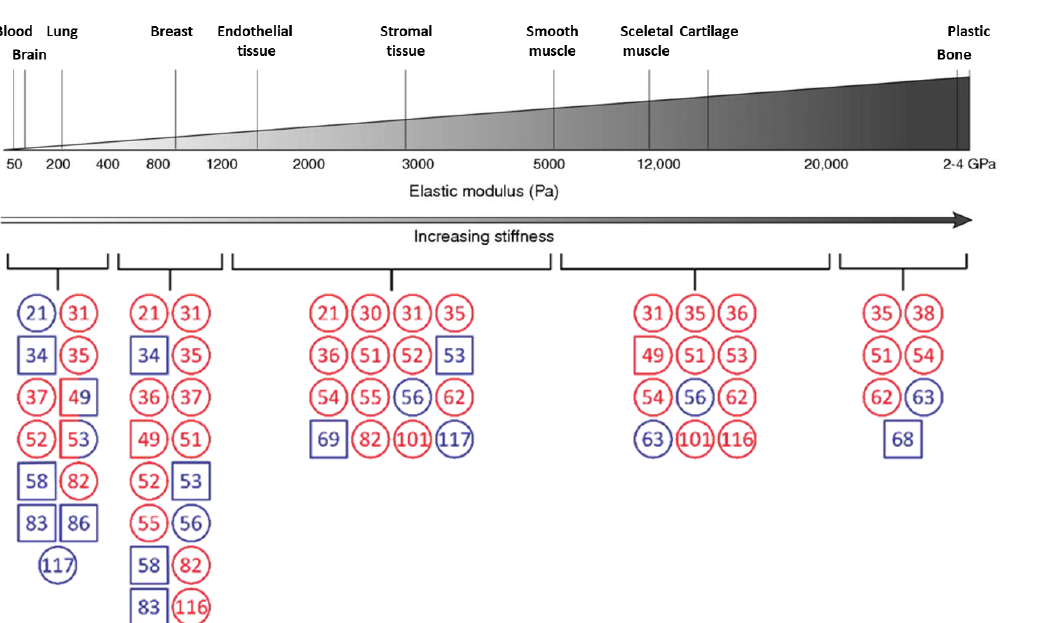
Figure 1. Summary of referenced stiffnesses in relation to different tissue stiffnesses (adapted from [13]). The data from the referenced literature cover a wide range of stiffnesses. Stiffness was divided into five ranges: up to 400 Pa, 400–1200